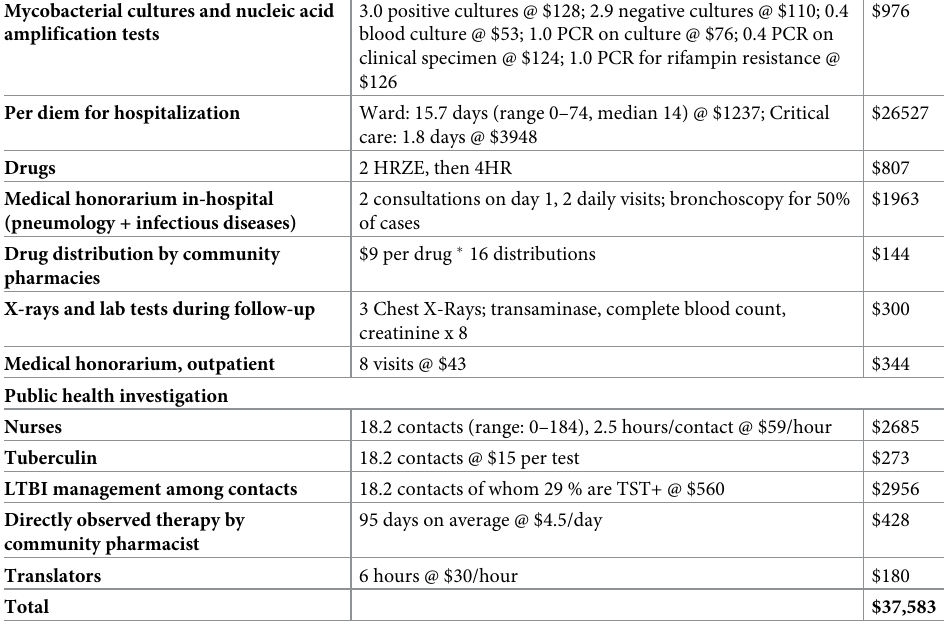
Table 4. Costs for each case of active tuberculosis in 2020 Canadian dollars, based on 43 foreign-born patients seen in 2007–2020. Mycobacterial cultures and nucleic acid amplification tests